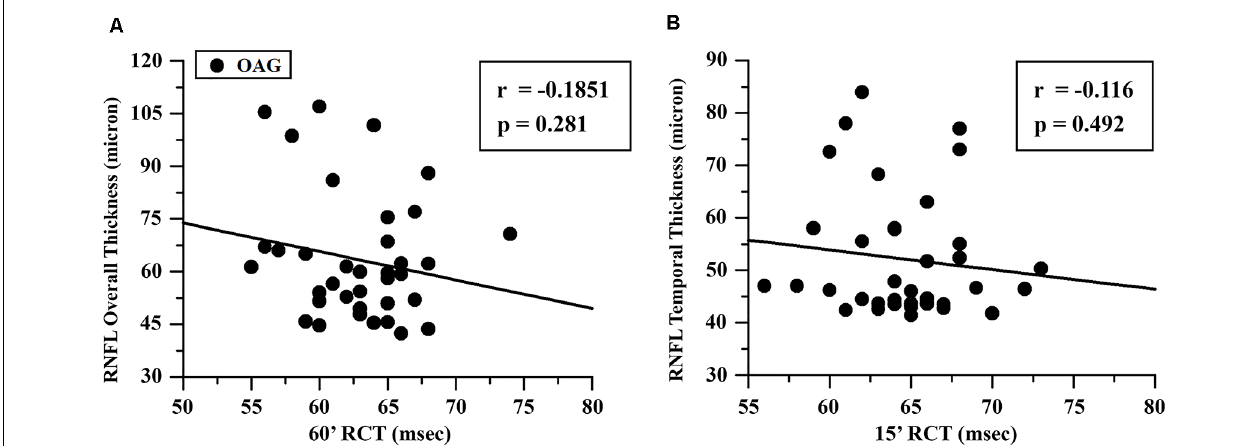
FIGURE 3 | OAG eyes: linear correlation between retinocortical time (RCT) and retinal nerve fiber layer (RNFL) thickness. RCT, difference VEP 100 minus PERG P50 implicit times; 60 (cid:48) (A) and 15 (cid:48) (B) , visual stimuli with checks subtending 60 and 15 min of visual arc, respectively; msec, milliseconds; µ ,